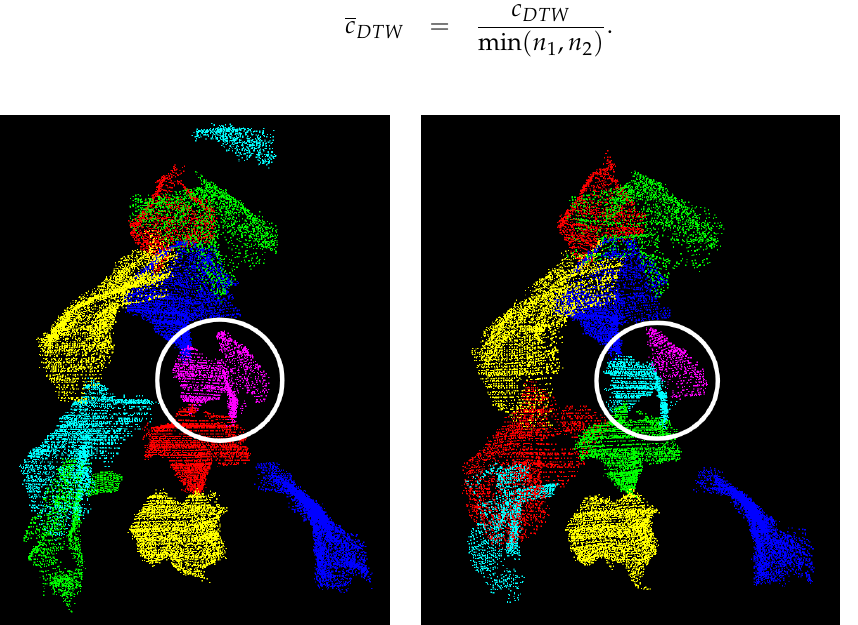
Figure 8. Spatial segmentation of two point clouds of the same plant. Points having the same colour belong to the same segment. There is no temporal link between the segments of the two point